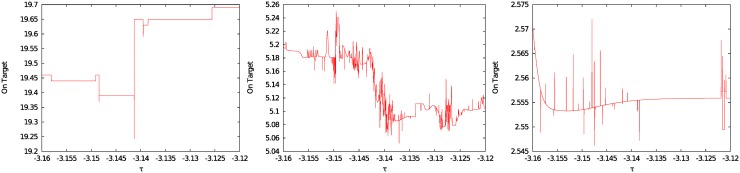
Mean value of rounds on target for 100 inputs over 40 rounds with P = const.Left: hargmax = 107, hsim = henv = 10. Center: hargmax = 103, hsim = henv = 10. Right: henv = 10, hargmax = hsim = 100. Note the different vertical axis ranges.